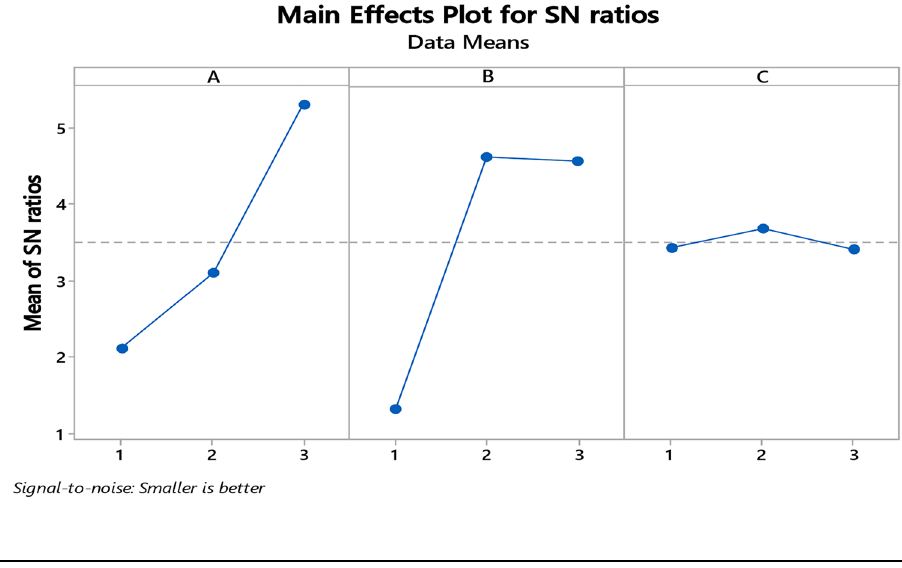
Fig. 4 Main effect plot for SN ratios ( A Speed, B Feed, C Depth of cut)